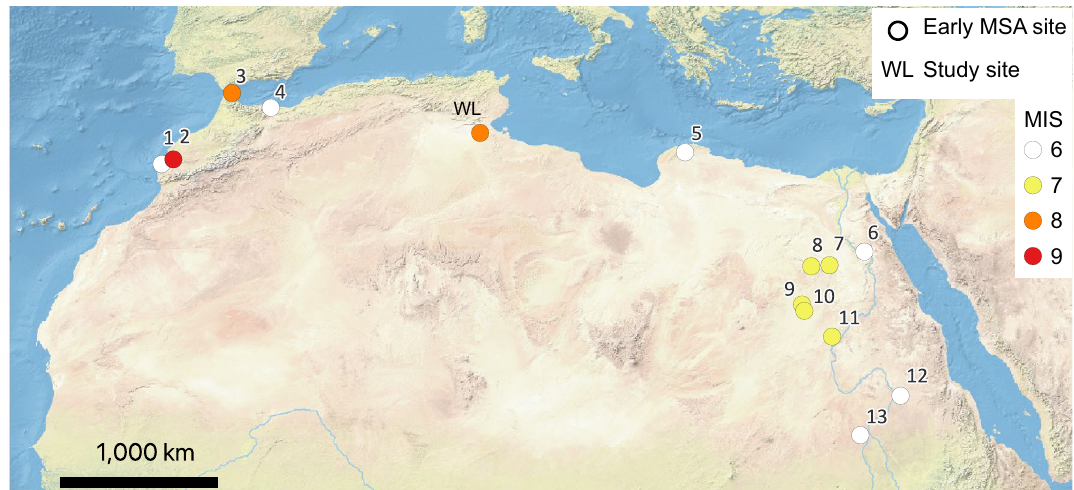
Figure 3. Map of Middle Pleistocene MSA contexts with chronometric estimates in North Africa (WL stands for Wadi Lazalim, the sites here discussed): 1, Bizmoune; 2, Jebel Irhoud; 3, Benzù; 4, Ifri n’Ammar; 5, Haua Fteah; 6, Taramsa 1; 7, Kharga; 8, Dakhla; 9, Bir Tarfawi; 10, Bir Sahara; 11, Sai 8-B-11; 12, EDAR 135; 13, Al Jamrab. Marine Isotopic Stage (MIS) of earliest estimated occupation is also indicated for each site (map created using QGIS 3.20.2 https:// qgis. org/ it/ site/; base map made with Natural